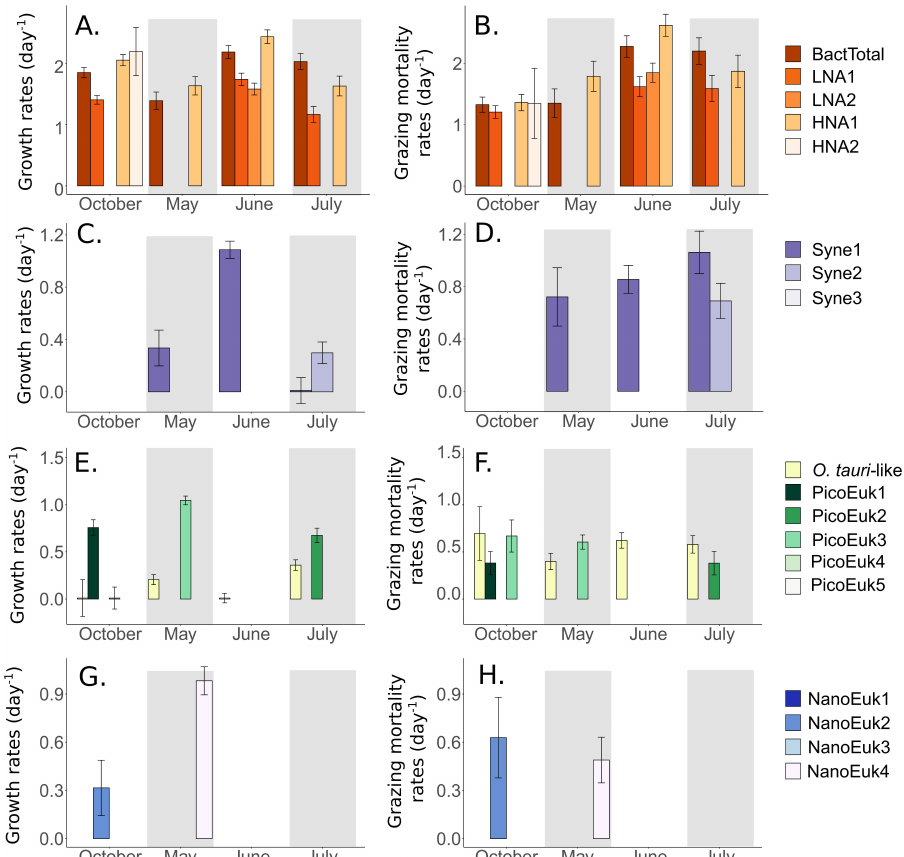
Figure 4. Growth and grazing mortality rates (day − 1 ) of different bacterial ( A , B ), cyanobacterial ( C , D ), eukaryotic picophytoplankton ( E , F ), and eukaryotic nanophytoplankton groups ( G , H ). White and gray columns help to distinguish different months in the figures.